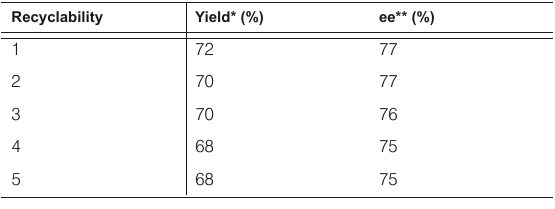
by silica gel column chromatography using a mixture of ethyl acetate and hexane as eluent.